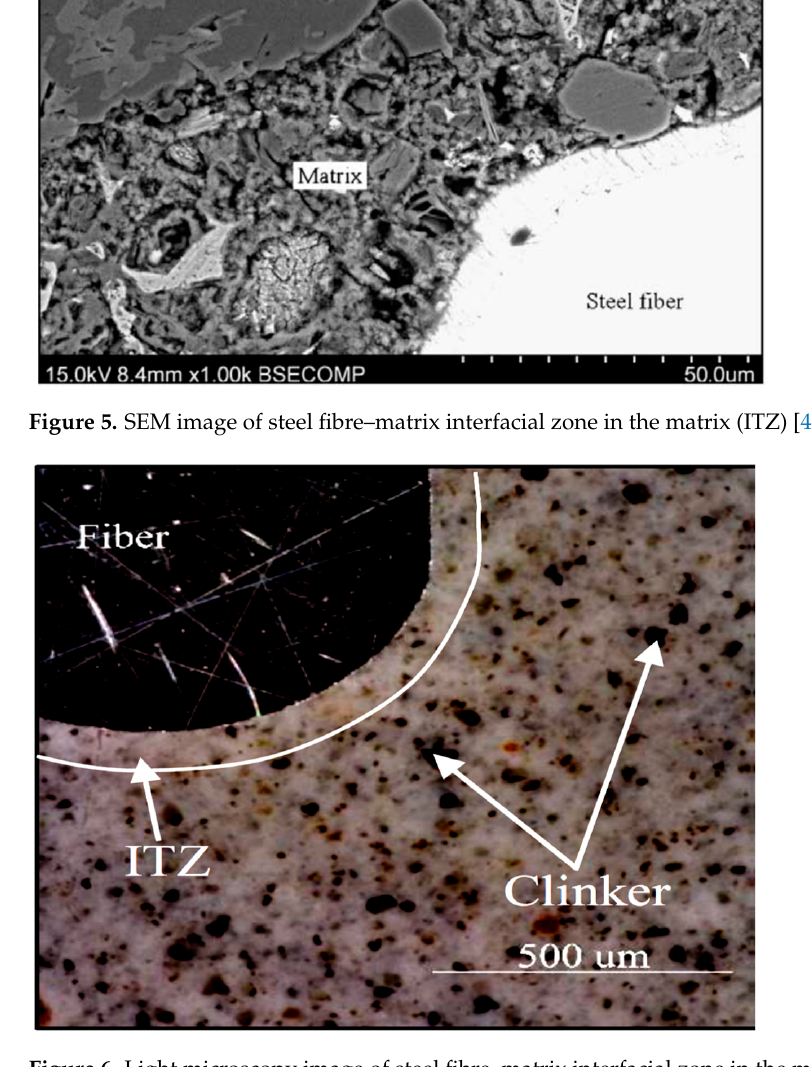
Figure 6. Light microscopy image of steel fibre–matrix interfacial zone in the matrix [51].